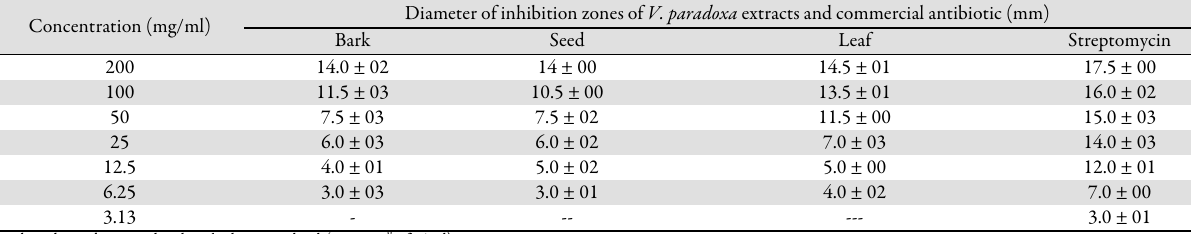
Table 4. Antimicrobial activity of V. paradoxa extracts against Klebsiella pneumoniae Concentration